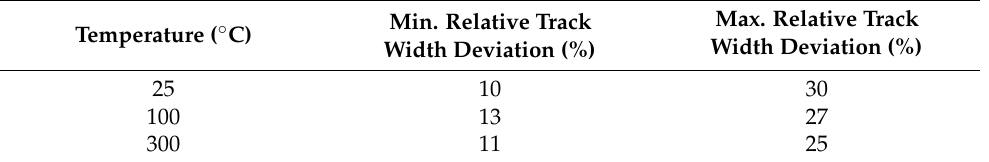
Table 4. Relative deviations between simulated and measured track widths.